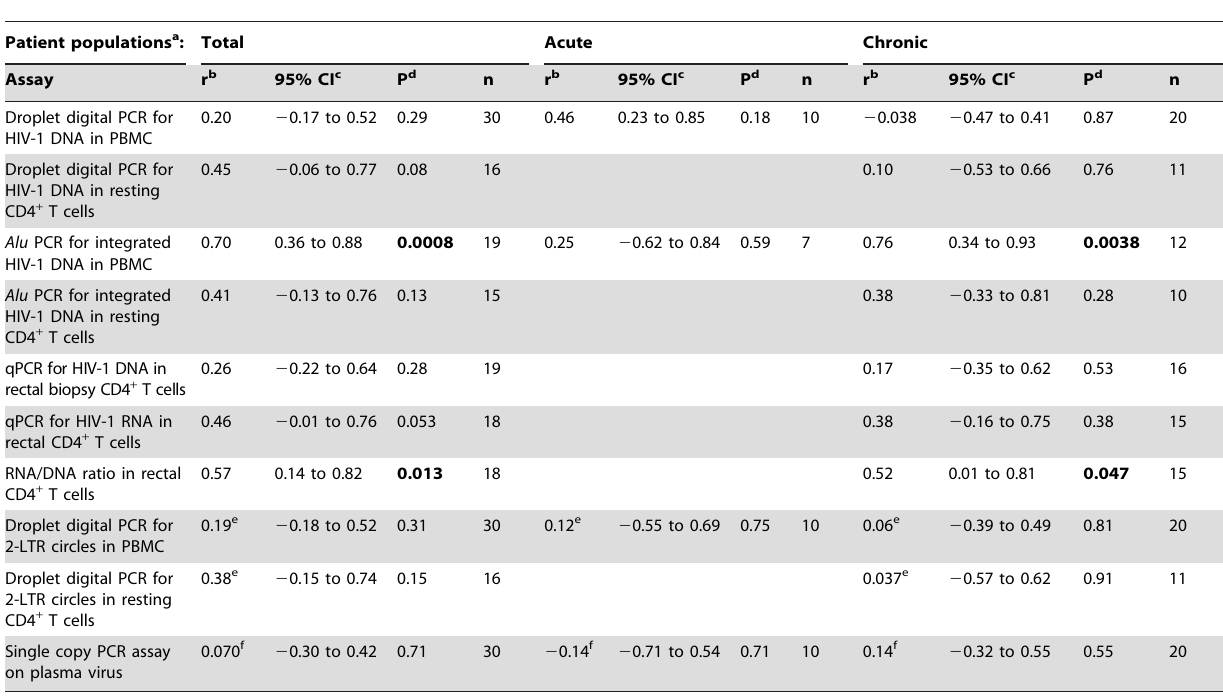
Table 4. Correlation of PCR-based assays with viral outgrowth assay.